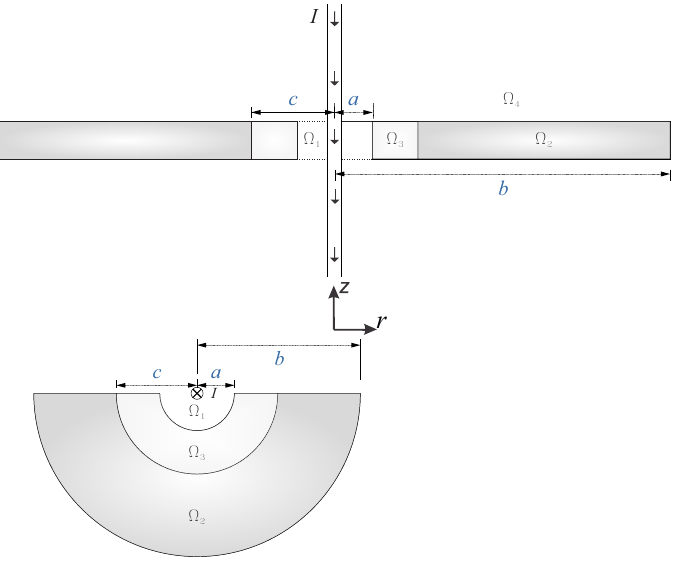
Figure 1. Geometry and parameters of the